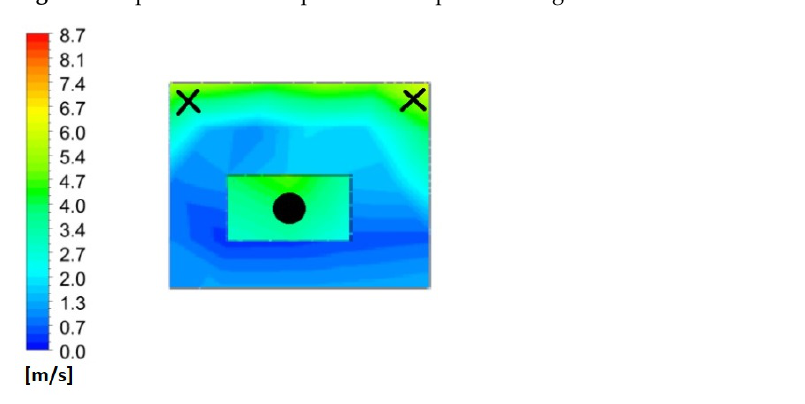
Figure 6. Top view of wind speed at the top of buildings.